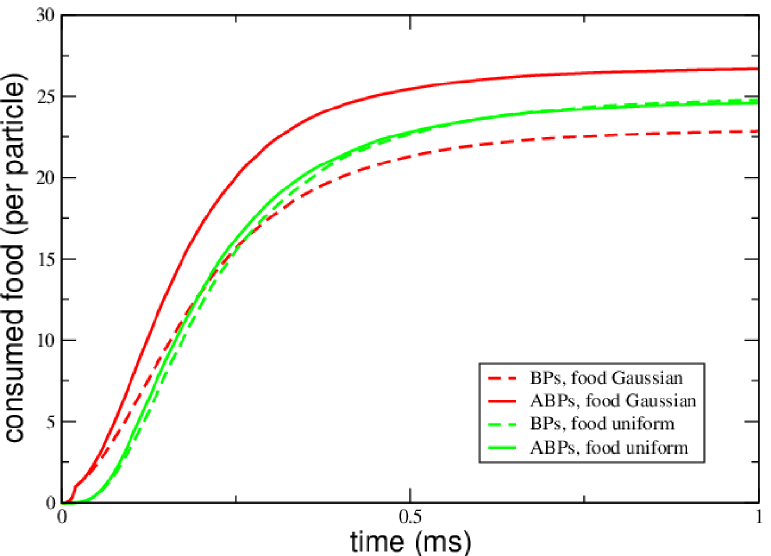
Fig 7. Non-stationary food consumption. Consumed food under the condition that the food concentration profile is a step function (green) or a Gaussian function (red). In the latter case, the ABPs experience an advantage over the passive BPs in terms of the amount of consumable